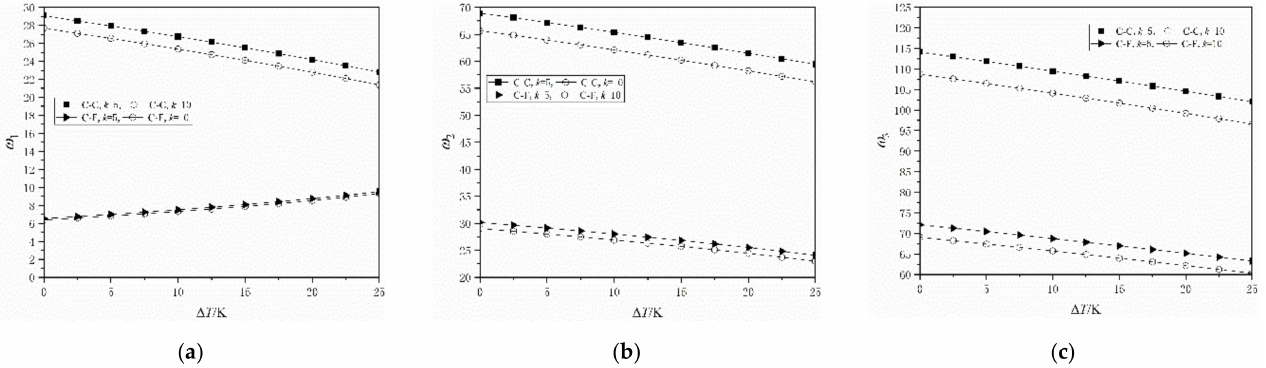
Figure 8. The relationship between dimensionless natural frequencies and the temperature change under two different boundary conditions (Kirchhoff plate). ( a ) The first-order frequencies; ( b ) The second-order frequencies; ( c ) The third-order